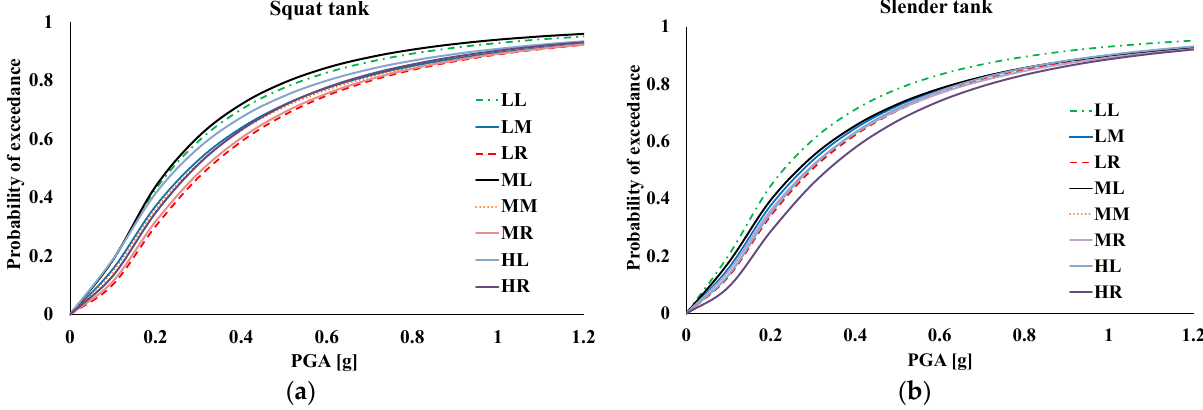
Figure 8. Fragility curves for MOGA2 designs for: ( a ) the squat and ( b ) slender tank.